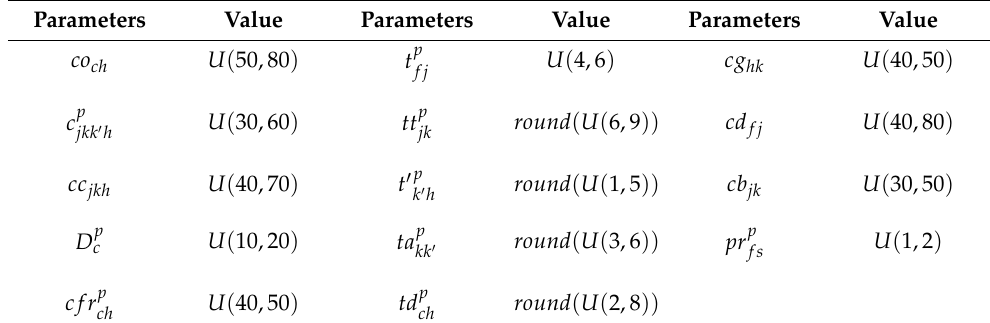
Table 2. The parameters of designed instances.